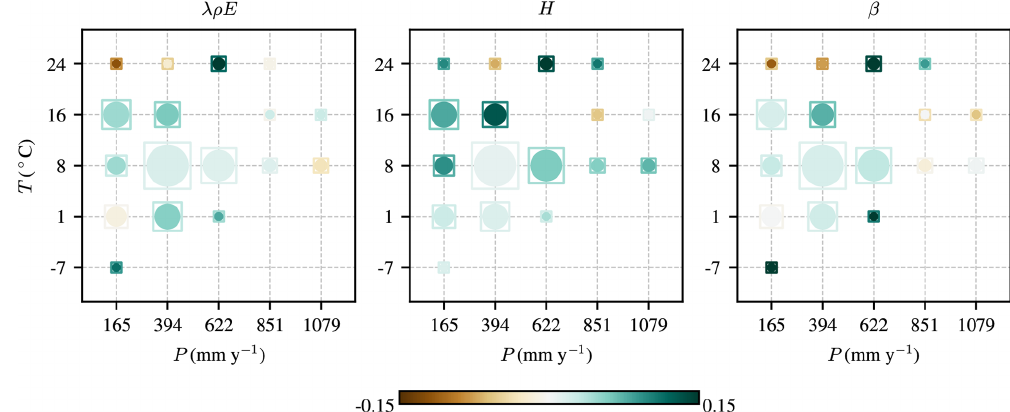
Figure 3. Difference between temporal validation statistics of the surface latent heat flux ( λρE ), surface sensible heat flux ( H ), and Bowen ratio ( β ) from ERA5 and ERA-I grouped as a function of precipitation rate ( P ) and near-surface air temperature ( T ) calculated at the in situ site. Statistics are calculated against in situ eddy-covariance measurements at daily resolution and then averaged across the sites within each group. Statistics include the MAD (anomaly in situ time series from 77 sites as reference) and R (anomaly in situ time series from 77 sites as reference). Circles show the R from ERA5 minus the one from ERA-I, while squares show the MAD from ERA-I minus the one from ERA5; hence, green colours represent better statistics for ERA5 compared to ERA-I. The size of the symbols relates to the number of in situ sites per